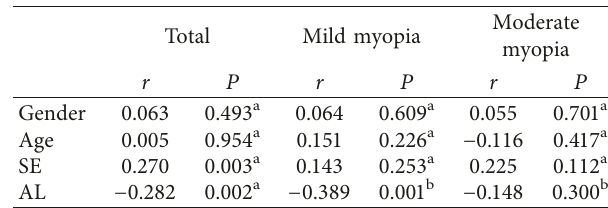
Figure 3: Choroidal thickness of vertical measured locations in mild and moderate myopia groups: S1, S2, and S3: 1, 2, and 3mm superior to the fovea; SF: subfoveal; I1, I2, and I3: 1, 2, and 3mm inferior to the fovea. Table 3: Correlations of subfoveal choroidal thickness with age, gender, spherical equivalent, and axial